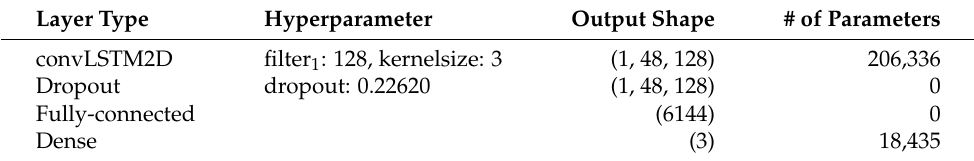
Table 6. A summary of all tuned model hyperparameters is given in Table 7. Table 6. Overview and details of the convLSTM architecture.The output shape is given for one batch.